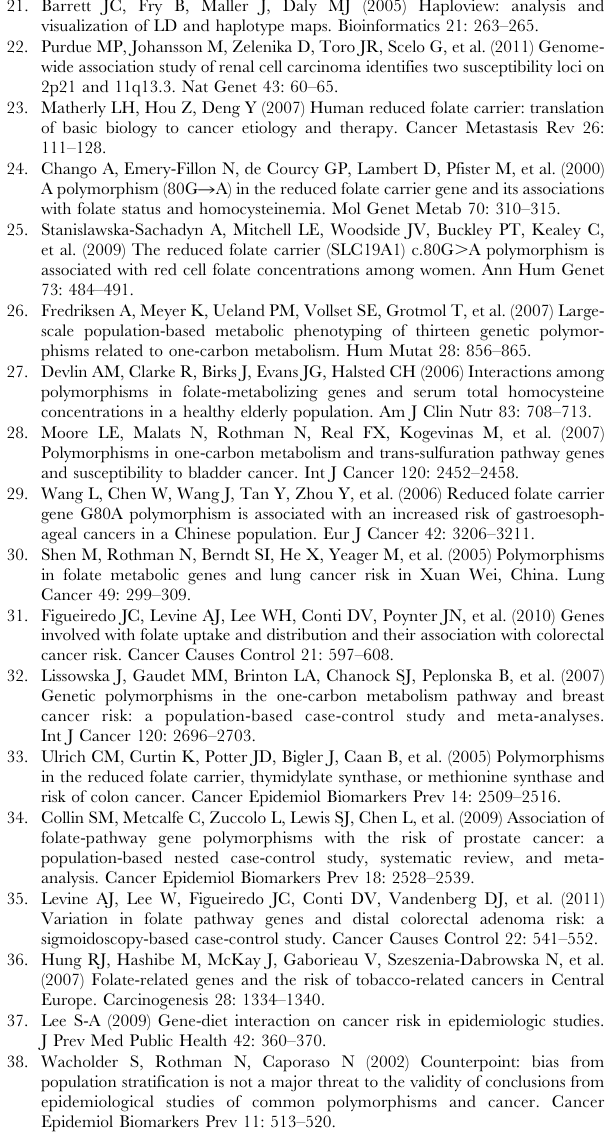
Figure S1 Reactions of one-carbon metabolism. A diagram showing the reactions of one-carbon metabolism (simplified), including the role of gene products from the 12 candidate genes in the analysis ( GGH not shown) and associated vitamin cofactors. Numbers in brackets [ # ] correspond to genes listed in Table 1.